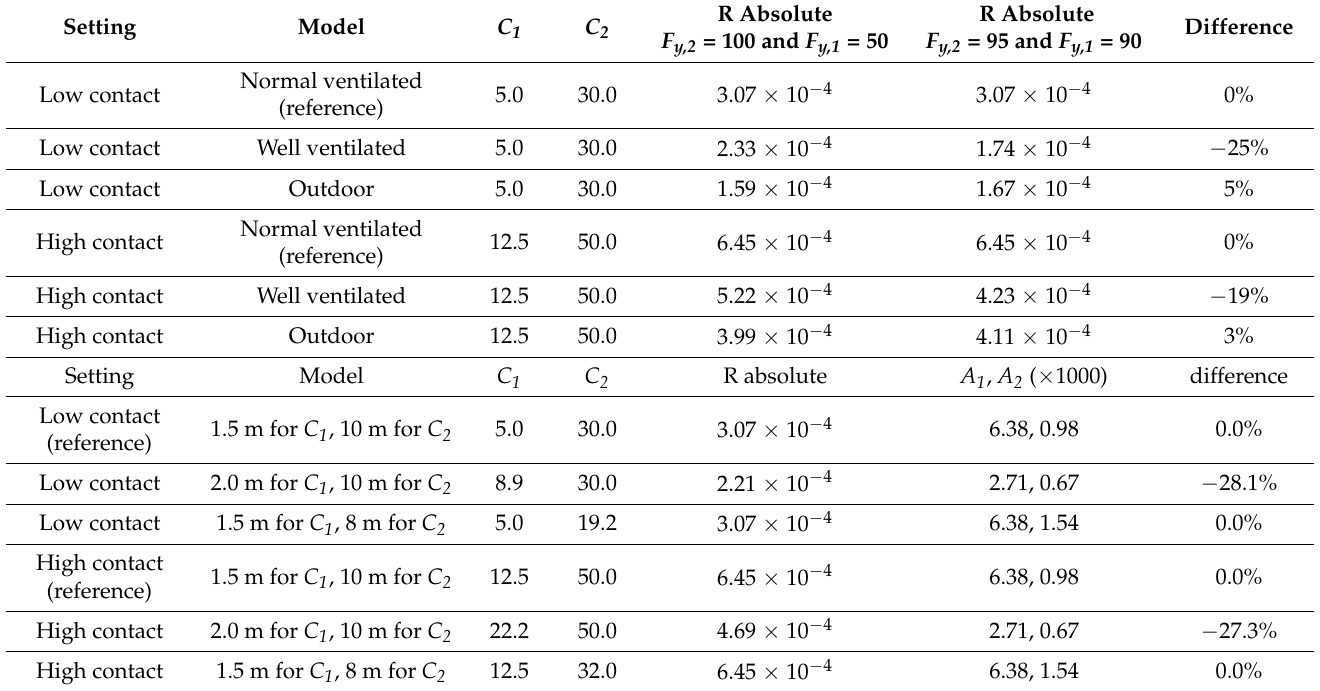
Table 3. Sensitivity analyses for ventilation and distance for contact classes. F V , F T , and F M are all